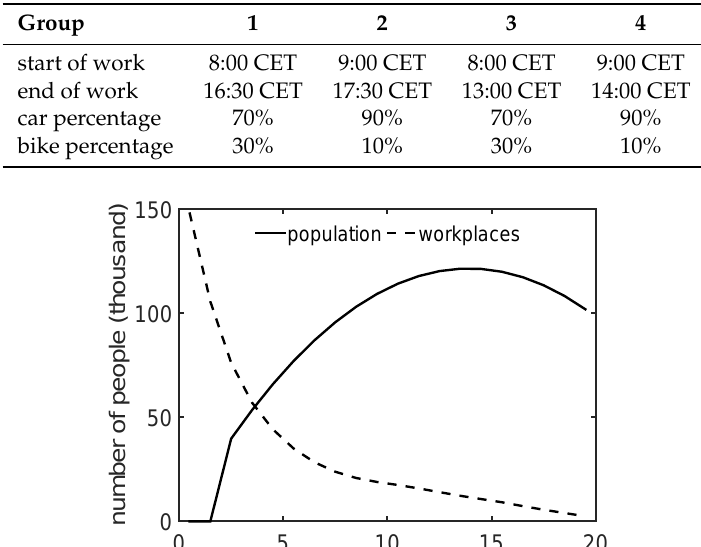
Table 2. List of constants for the different groups.